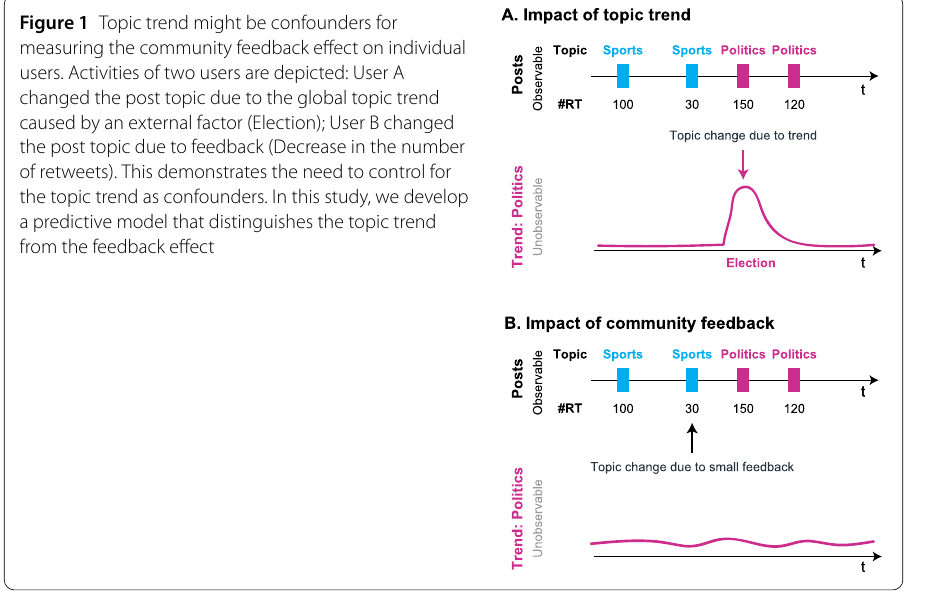
Figure 1 Topic trend might be confounders for measuring the community feedback effect on individual users. Activities of two users are depicted: User A changed the post topic due to the global topic trend caused by an external factor (Election); User B changed the post topic due to feedback (Decrease in the number of retweets). This demonstrates the need to control for the topic trend as confounders. In this study, we